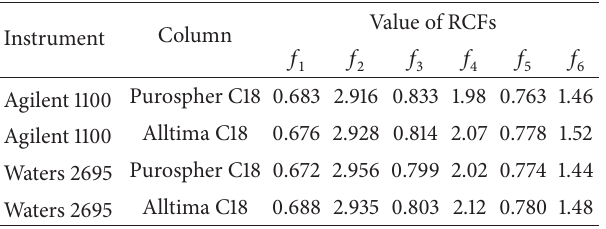
Table 5: The values of 𝑓 calculated with different columns and instruments ( 𝑛 = 3